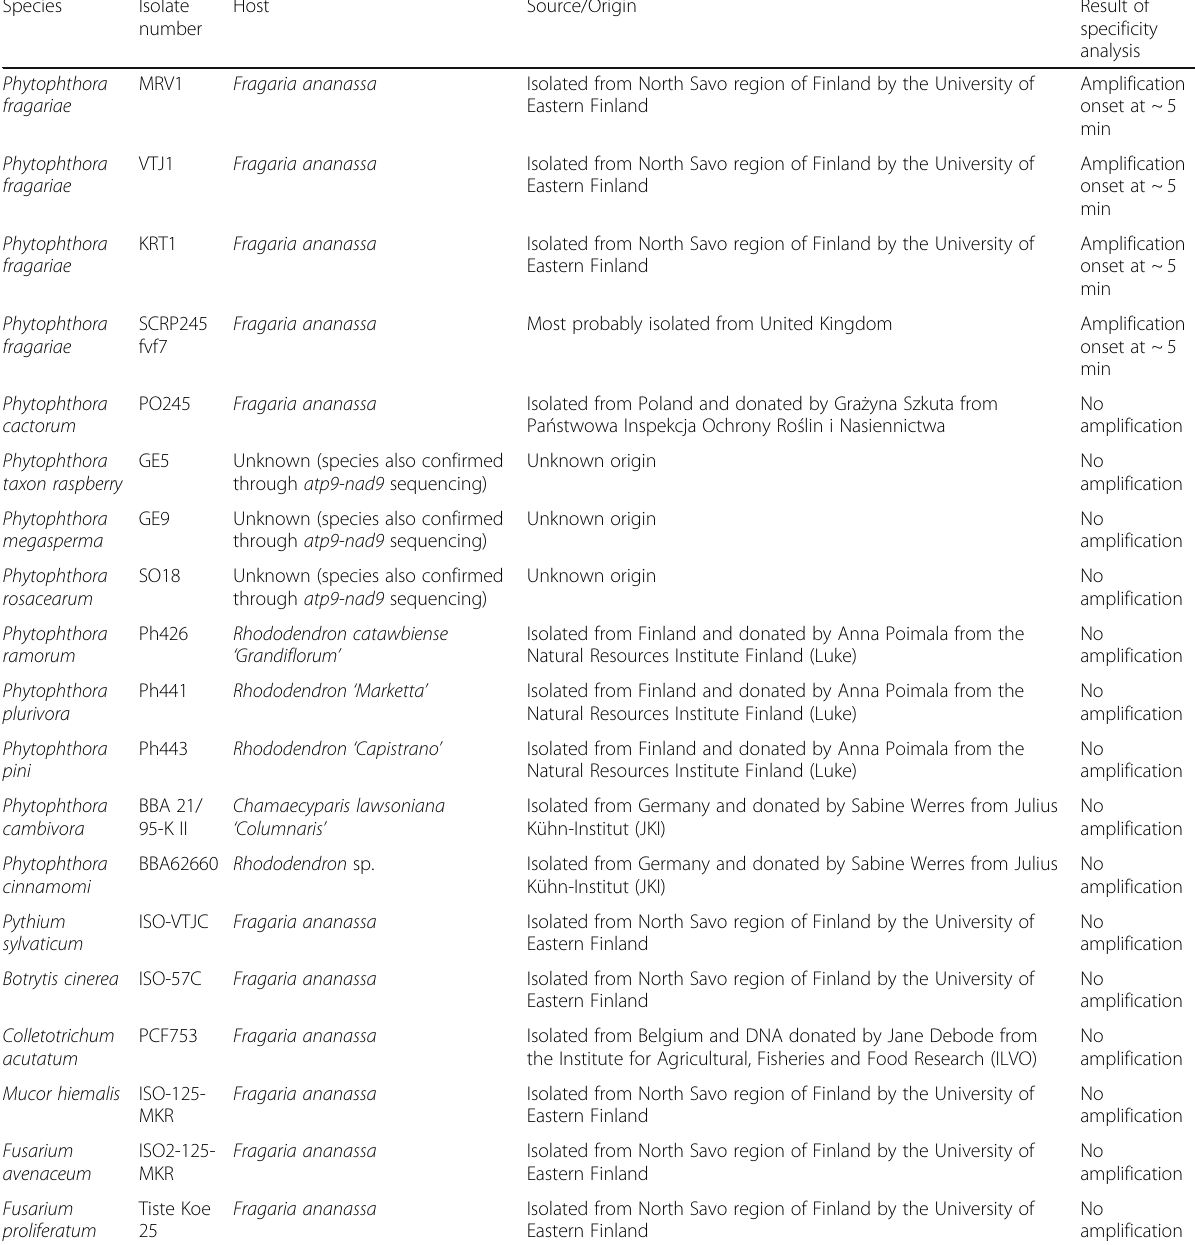
Table 2 Isolates utilized in sensitivity and specificity analyses and their origins